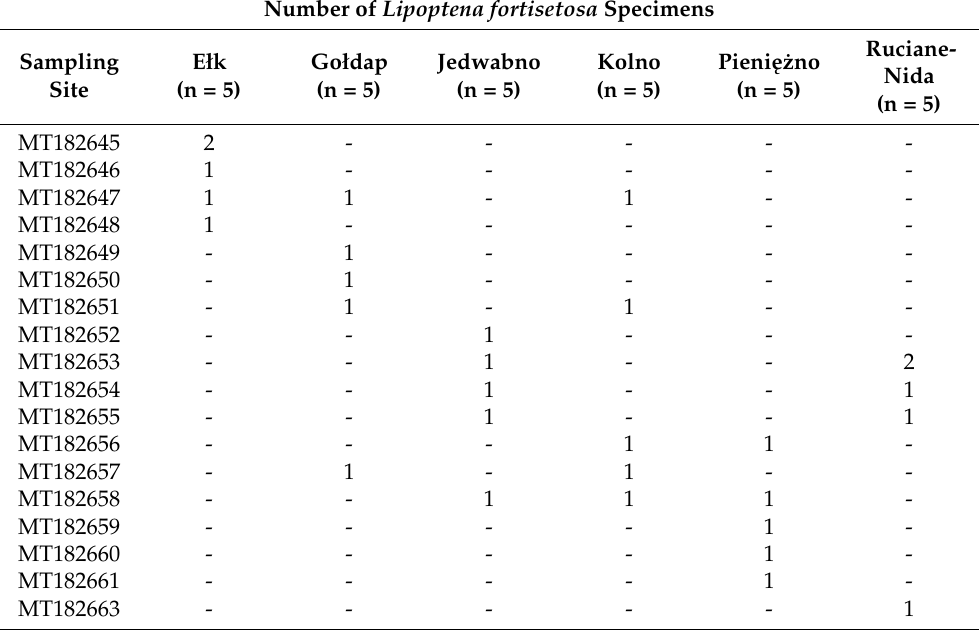
Table 3. Molecular characteristics of Lipoptena fortisetosa in sampling